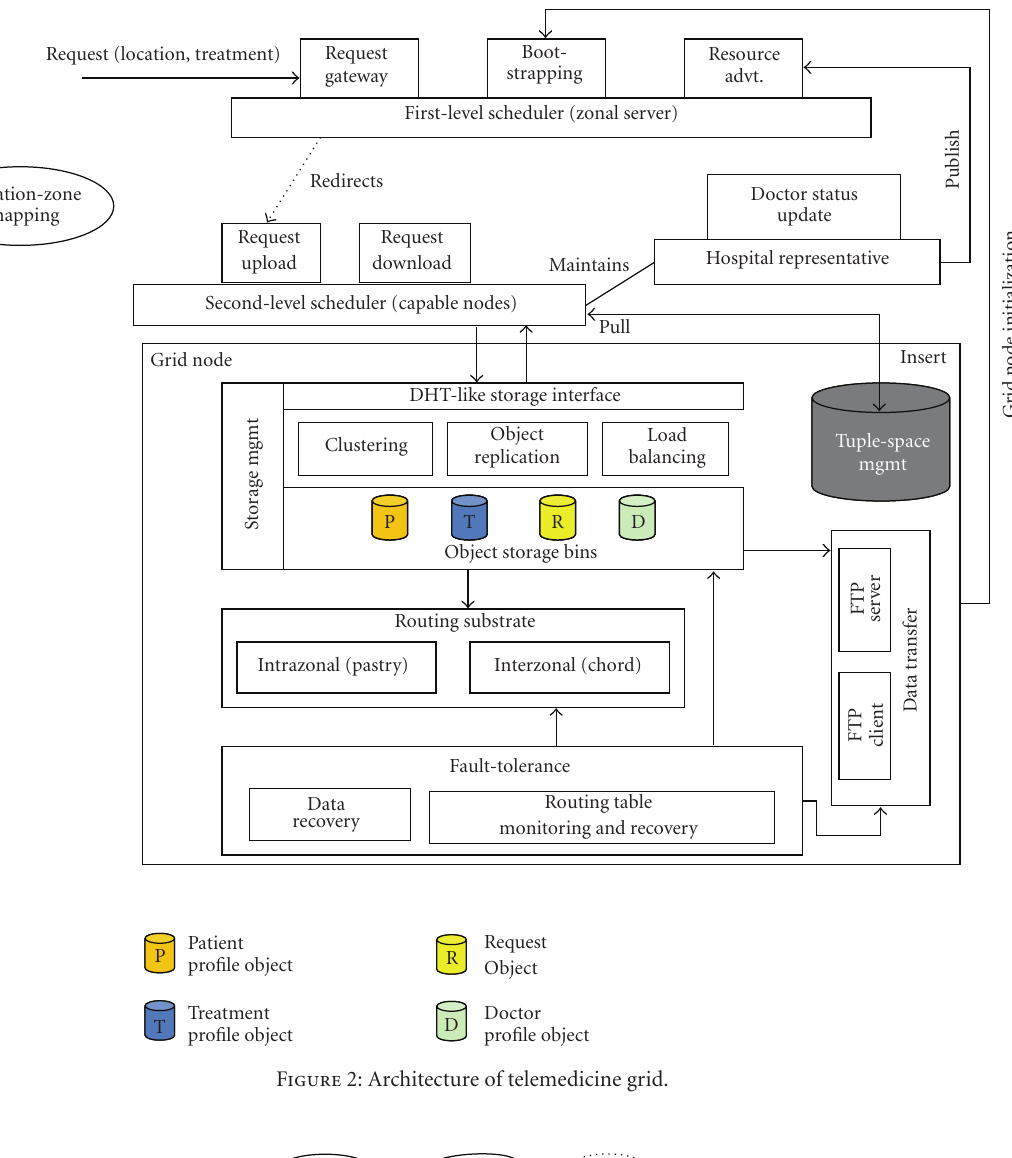
Figure 2: Architecture of telemedicine grid.